Question: Which visualization type does this figure use?
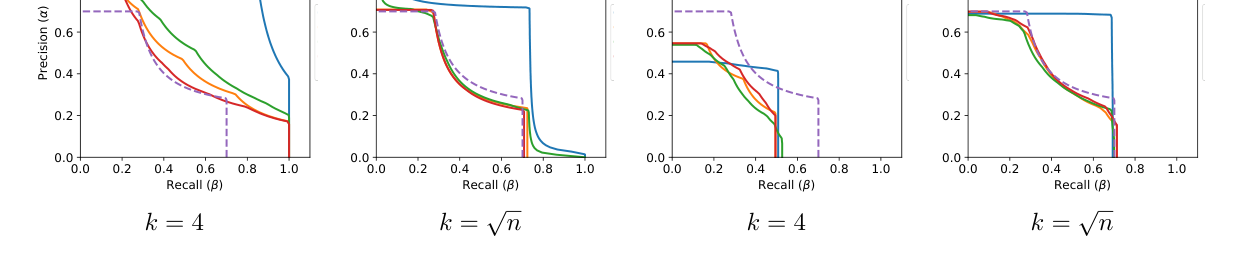
Answer: line